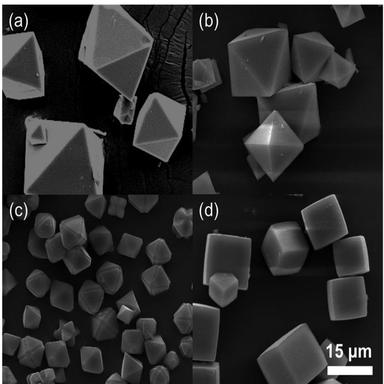
SEM images of Cr-embedded MOF-199 with Cr/Cu molar ratios of (a) 0:1, (b) 0.05:1, (c) 0.1: 1, and (d) 0.2:1. Reprinted with permission from Ref. .